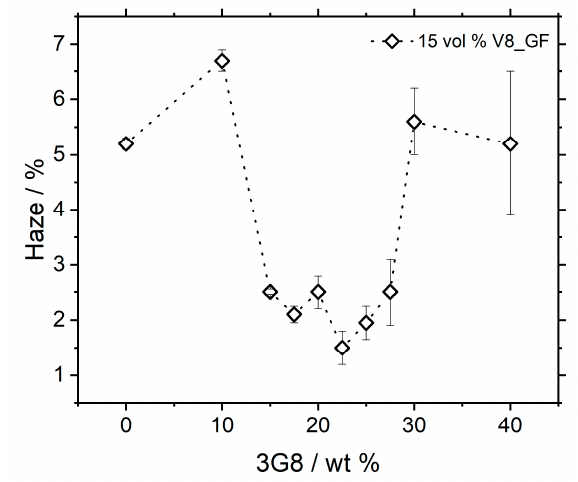
Figure 16. Haze values of composites with 15 vol % of GF-V8 MGF with respect to different contents of softener (3G8). All results were normalized to 200 µm sheet thickness.